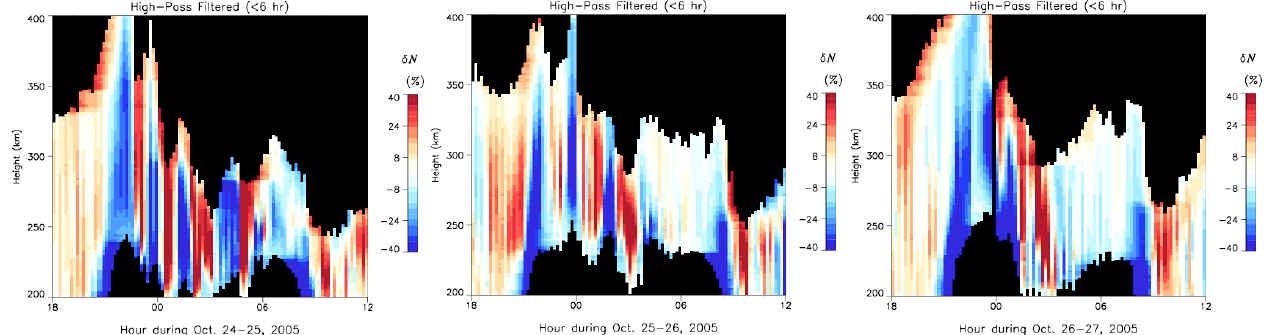
Fig. 3. Electron density fluctuations computed from the digisonde data for the three nights of 24 to 27 October 2005 from 18:00 to 12:00UT. Note the large electron density fluctuations (up to ∼ 40%), with oscillation periods of ∼ 20min to 2h and apparent downward phase progres- sions at altitudes of ∼ 280km and below. Note that large K p values ( ∼ 4) occurred only on 25 October, with smaller values the following